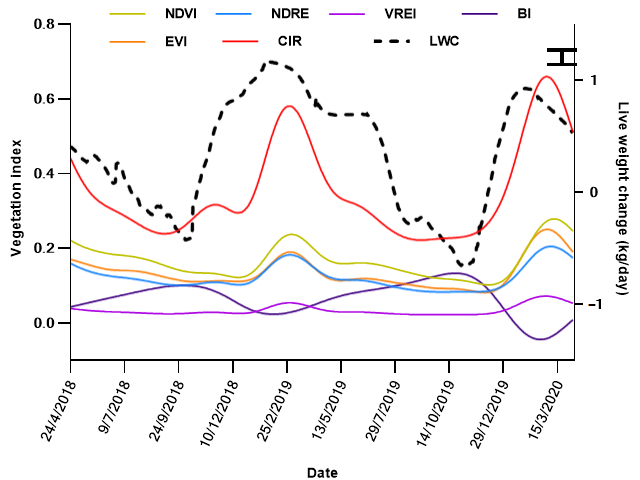
Figure 3. Temporal trends in vegetation indices using Sentinel-2 satellite imagery from a paddock grazed by cattle and daily growth rate of cattle (LWC) over a two-year period. There were significant relationships between all VIs and the LWC of cattle ( p < 0.001; Table 4). Regression coefficients for all VIs except BI showed positive values ( p < 0.001). of the animals reflected in a negative intercept (Table 4). Table 4. Linear mixed-effect regression models of vegetation indices and live weight change of graz- ing cattle calculated from Sentinel-2 satellite imagery in both experimental years.